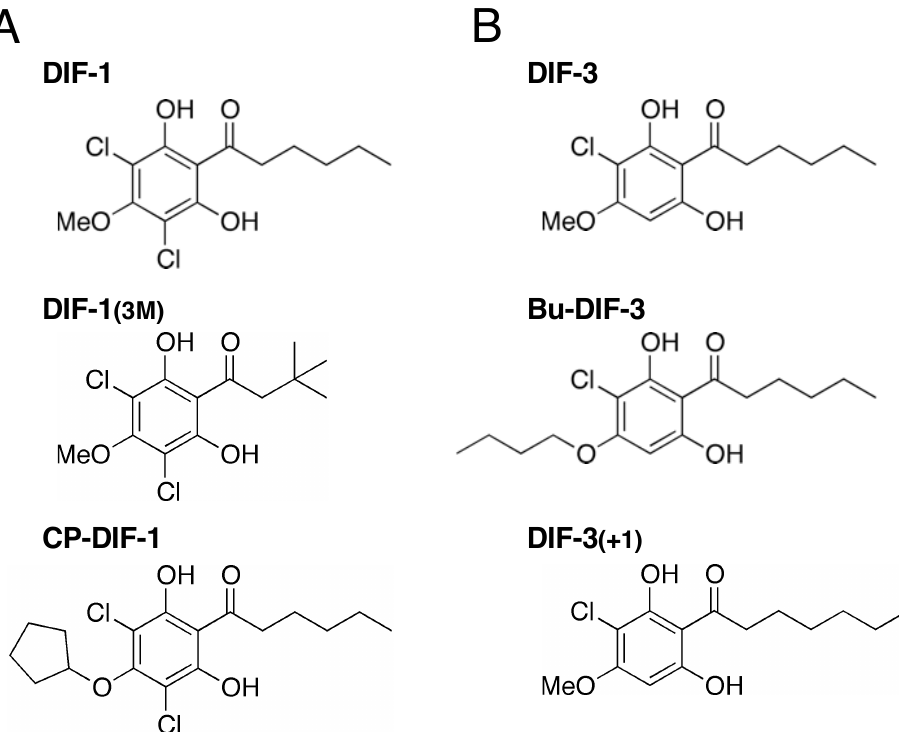
Figure 1. Chemical structure of differentiation-inducing factors. ( A ) DIF-1 and its derivatives used in this study. ( B ) DIF-3 and its derivatives that possess strong antitumor